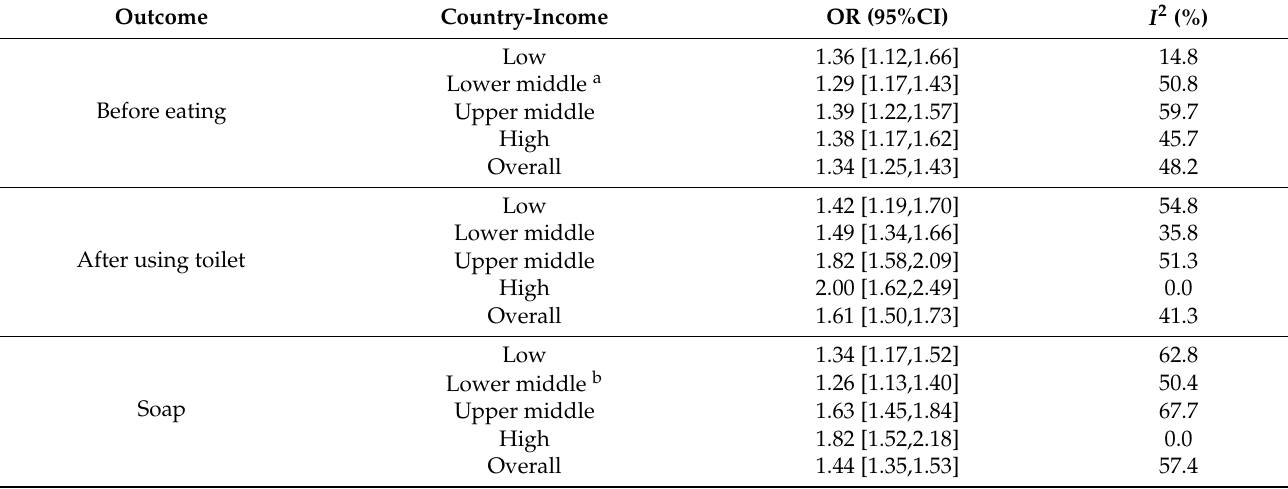
Abbreviation: OR Odds ratio; CI Confidence interval; Country-wise estimates were adjusted for age and sex; a Laos was not included because estimates could not be obtained due to small numbers; b Laos and Northern Macedonia were not included because estimates could not be obtained due to small